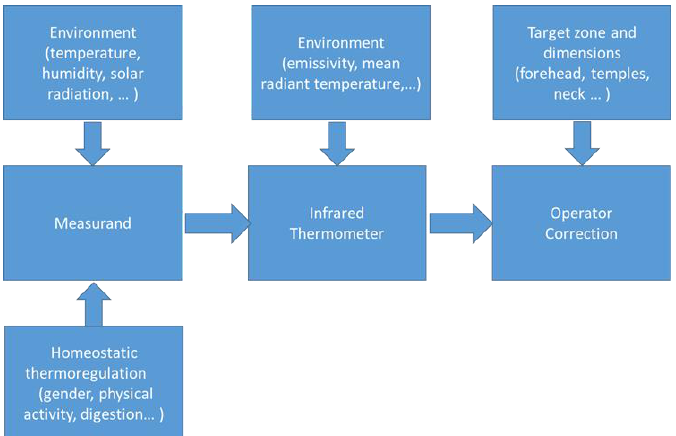
Figure 1. Measuring chain of noncontact body temperature measurement.